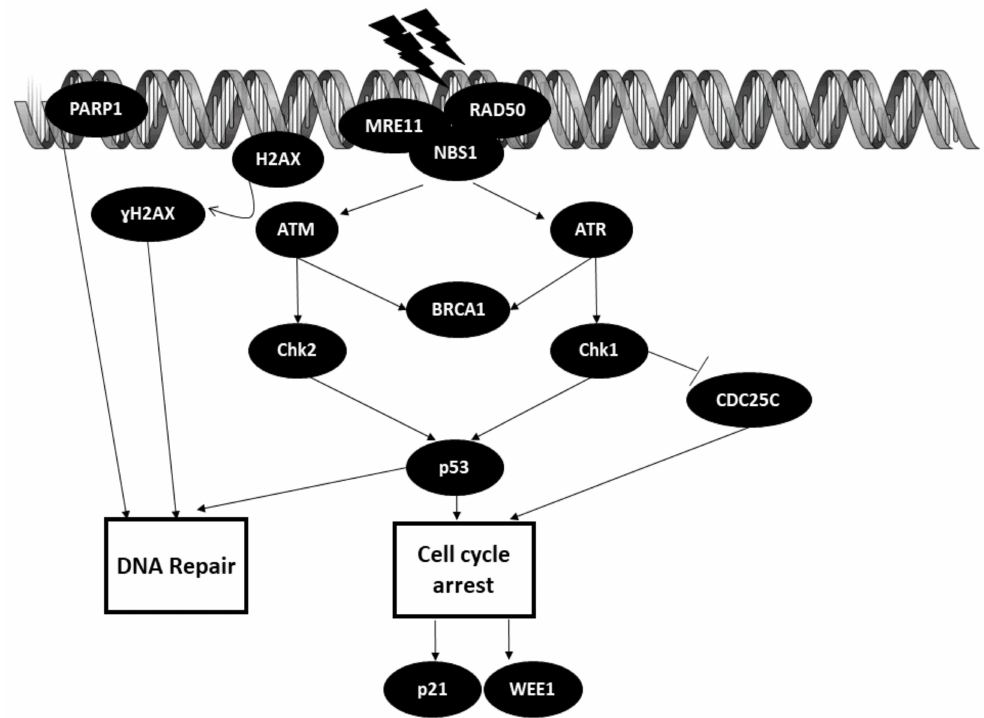
Figure 3. Crucial regulators of DNA damage repair (DDR) mechanism. PARP1: Poly (ADP-ribose) polymerase 1; MRE11: meiotic recombination 11 homolog; NBS1: Nijmegen breakage syndrome protein 1; ATM: Ataxia–telangiectasia mutated; H2AX: H2A histone family member X; ATR: Ataxia–telangiectasia and Rad3-related; BRCA1: Breast cancer 1; Chk2: Checkpoint kinase 2; Chk1: Checkpoint kinase